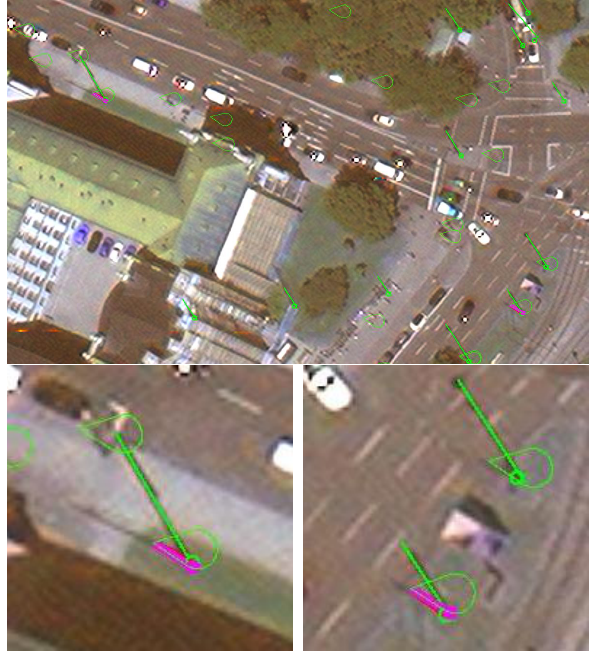
Figure 16. top: section 120 × 75 m 2 of fig. 15 (left of center, Elisenstraße), bottom: details ( 20 × 20 m 2 ) with determined corrections as pink lines from pole footpoint to